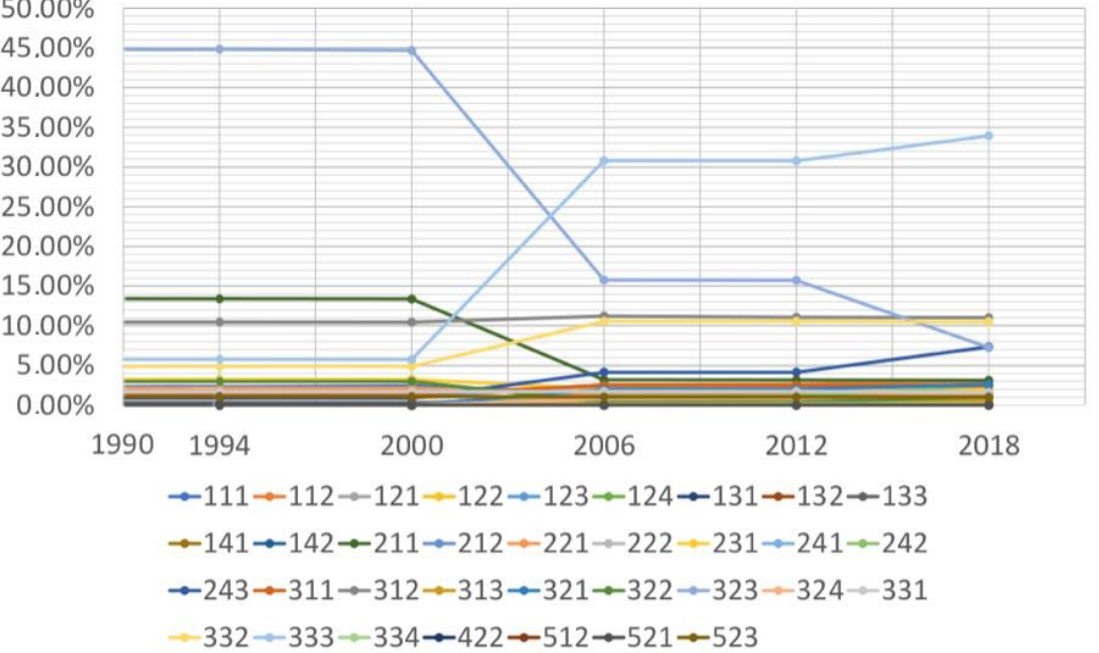
Figure 5. Percentages of land use in Canary Islands according to CORINE land-cover nomenclature for level 3 in 1990, 2000, 2006, 2012 and 2018. Table 3. Percentage of artificial surfaces according to CORINE land cover nomenclature for level 3 in Canary Island in 1990, 2000, 2006, 2012 and 2018 (Source: authors). Code